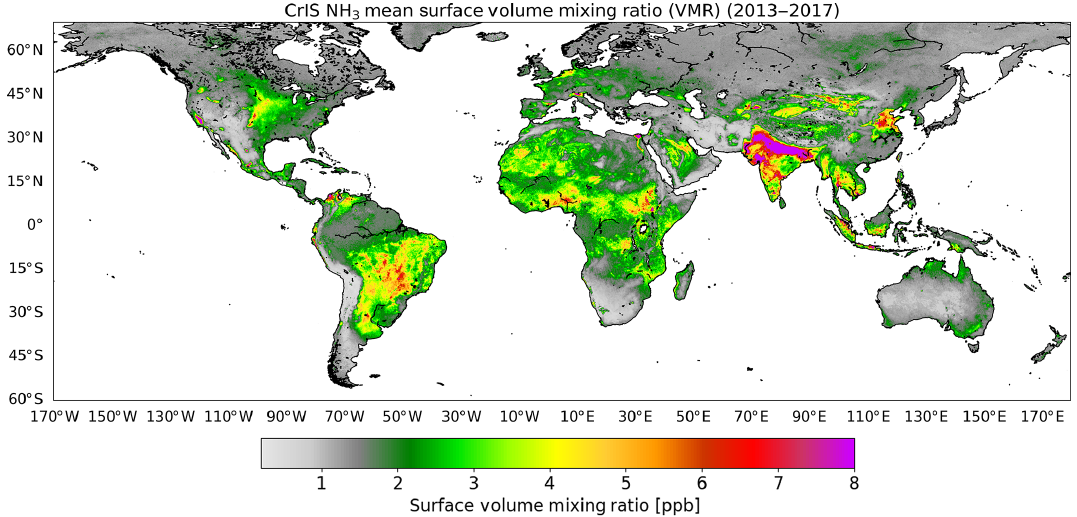
Figure 5. CrIS 5-year mean (2013–2017) of surface ammonia globally over land. The CrIS mean gridded Level 3 values are generated on a uniform 0 . 05 ◦ × 0 . 05 ◦ ( ∼ 5km × 5km) grid with a quality flag of